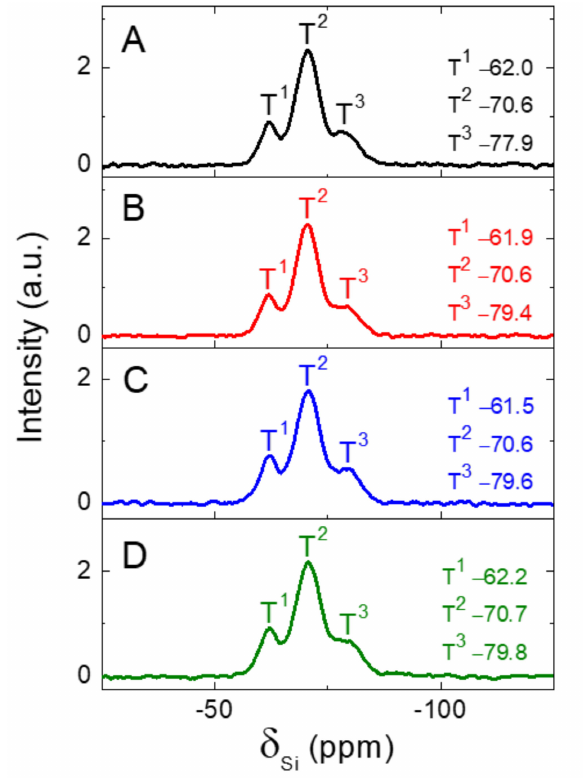
Figure 10. 29 Si CP-MAS NMR of mesoporous organosilica samples: PMOA-2 ( A ), PMOA-4 ( B ), PMOB-1 ( C ), PMOB-3 ( D ).